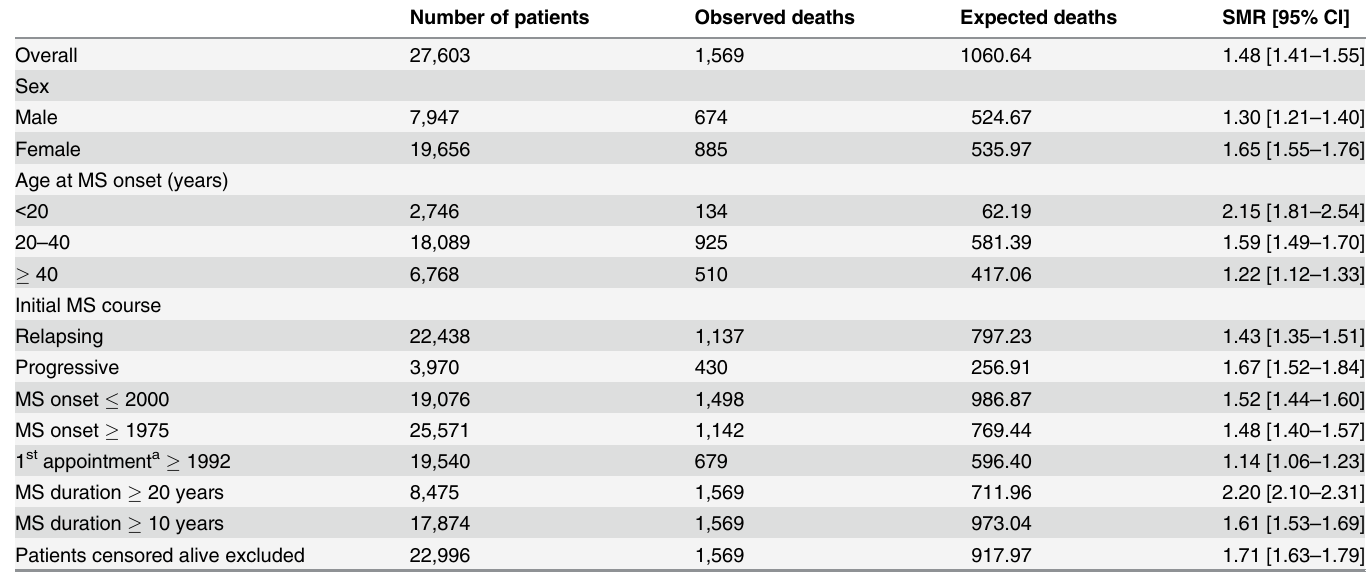
Table 4. Overall and subgroup comparisons of mortality between MS patients and the French general population using Standardized Mortality Ratios (SMR estimates with 95% CI, Poisson